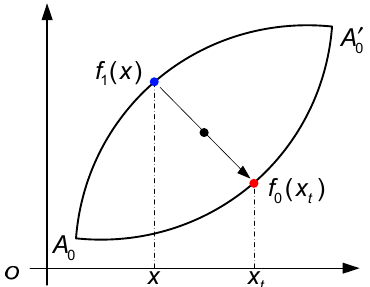
Figure 4. Translation of points on f 1 ( x ) to corresponding points on f 0 ( x ) .